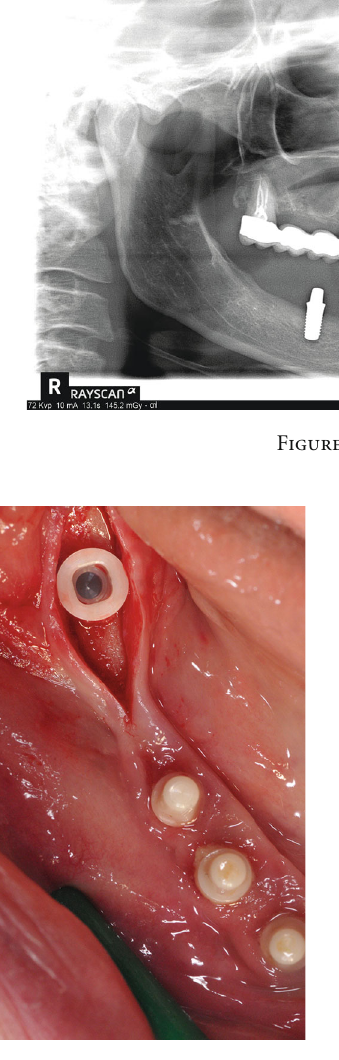
Figure 9: Placement of a two-piece zirconia in the posterior area after implant failure.